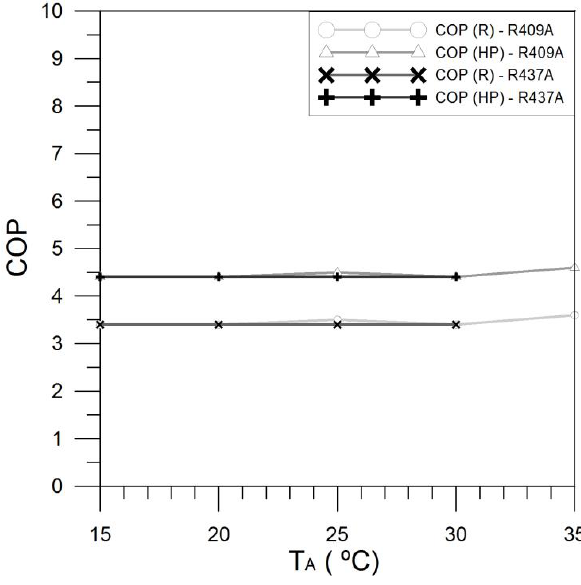
Figure 10: Effect of the heat source temperature on COP (Group A of tests).